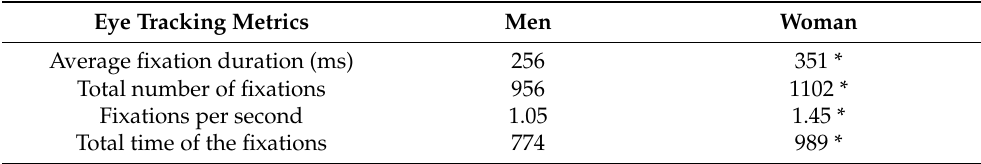
Table 3. Test of Kruskal Wallis (* p <